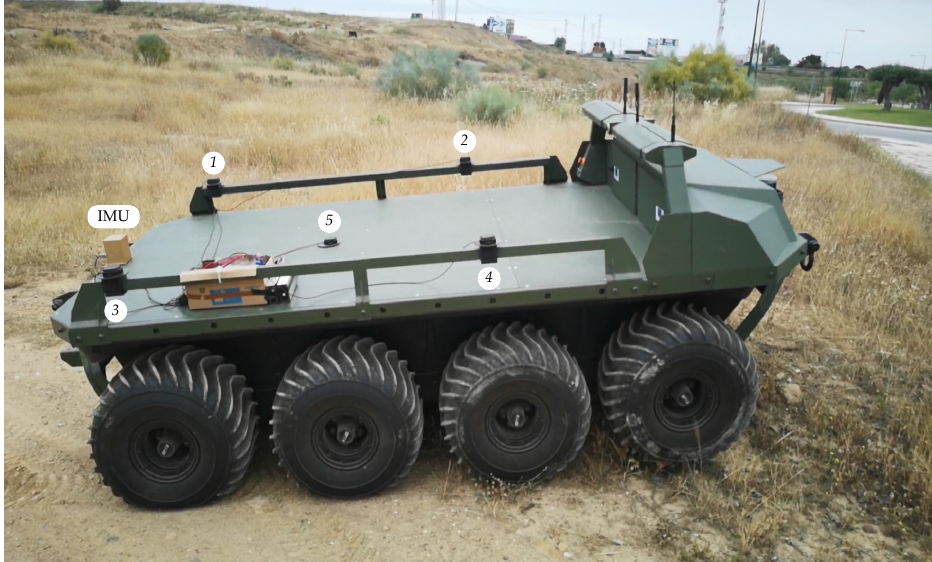
Figure 7. The rover Argo XTR with the sensor system mounted on the rear deck. GNSS antennas are numbered from 1 to